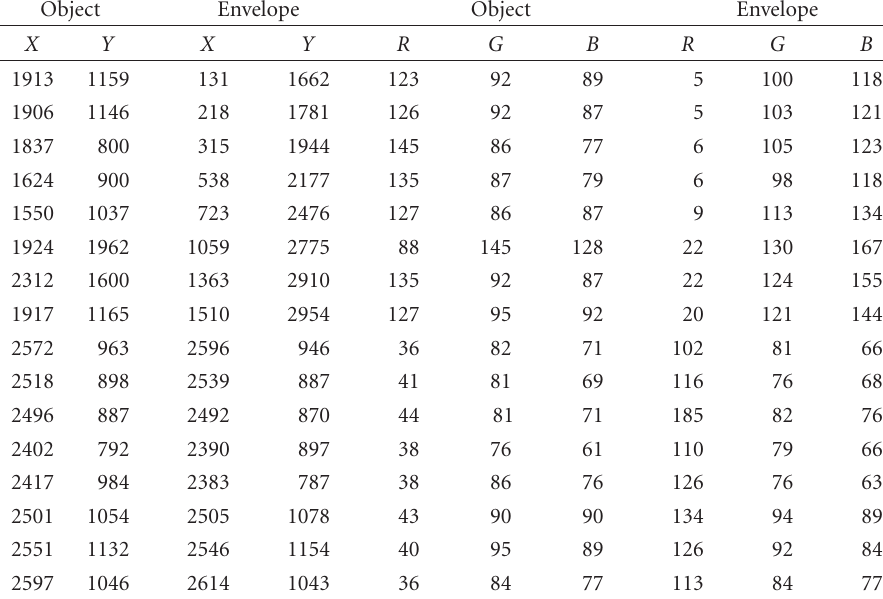
Table 4.4. Data recorded from Figure 4.4 for